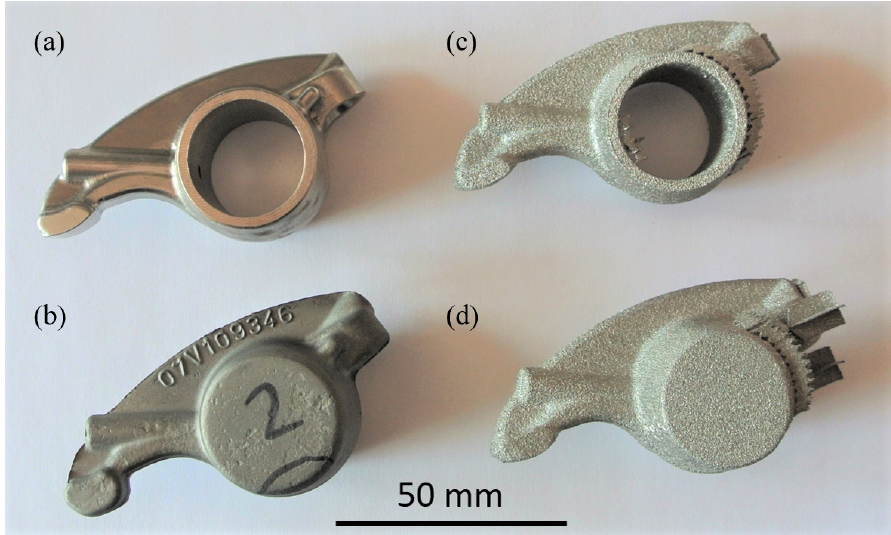
Figure 1. Ti-6Al-4V valve train rocker arms manufactured through the University of Sheffield by the following metal additive and hybrid powder metallurgy process routes: ( a ) FAST- forge with post-process finish machining; ( b ) FAST- forge ; ( c ) SEBM metal additive; and ( d ) SEBM metal additive with additional machining stock. The forging of the FAST- forge components ( a , b ) was carried out by Victoria Forgings,